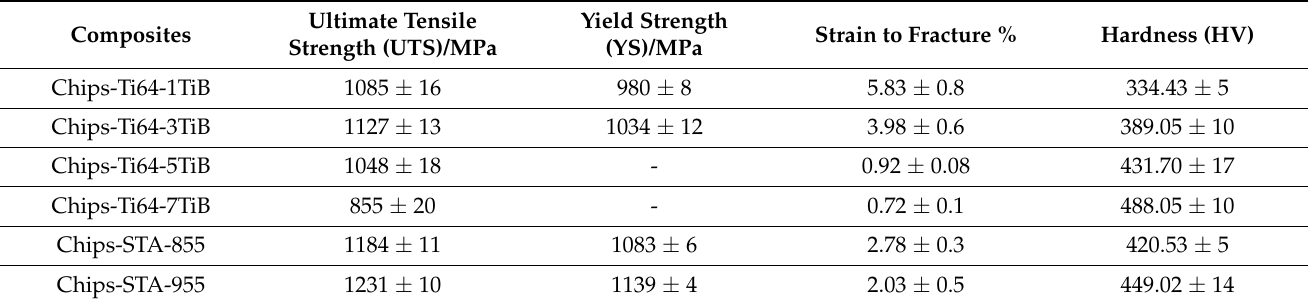
Table 5. Mechanical properties of the fabricated Chips-Ti64-xTiB composites and Chips-Ti64-3TiB after different heat treatments.